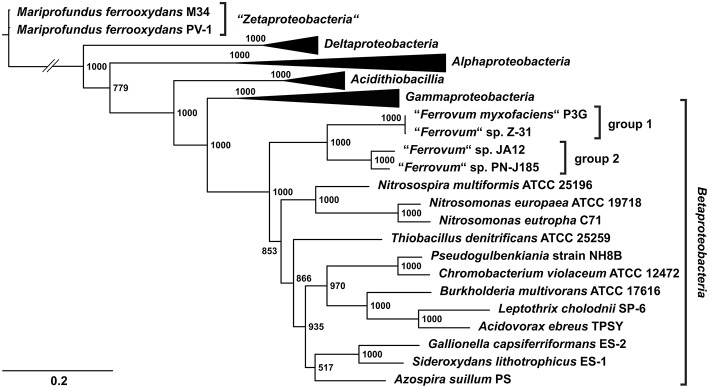
Phylogenetic tree of the four “Ferrovum” strains based on 31 concatenated protein sequences according to (Ciccarelli et al., 2006). Concatenated protein sequences of 31 universal markers (Ciccarelli et al., 2006) were aligned using MAFFT (Katoh et al., 2002; Katoh and Standley, 2013). The Maximum likelihood tree was constructed only including informative regions of the multiple sequences alignments using PhyML (Guindon et al., 2010) based on the Whelan & Goldman model (Whelan and Goldman, 2001). Phylogeny was tested using the bootstrap method with 1000 replications. Several subtrees were collapsed. The Alphaproteobacteria are represented by Rhodopseudomonas palustris TIE-1, Rhodomicrobium vannielii ATCC 17100, Paracoccus denitrificans PD1222 and Acidiphilium cryptum JF-5; the Deltaproteobacteria by Geobacter metallireducens GS-15 and Geobacter uraniireducens Rf4; Gammaproteobacteria by Alcanivorax borkumensis SK2, Escherichia coli K12 substr. MG1655 and Nitrosococcus oceani ATCC 19707; the Acidithiobacillia by Acidithiobacillus caldus SM-1, Acidithiobacillus ferrivorans SS3 and A. ferrooxidans ATCC 23270. Accession numbers of the genome sequences are given in Supplementary Table 1. The two subbranches harboring the “Ferrovum” strains were defined as group 1 and 2.